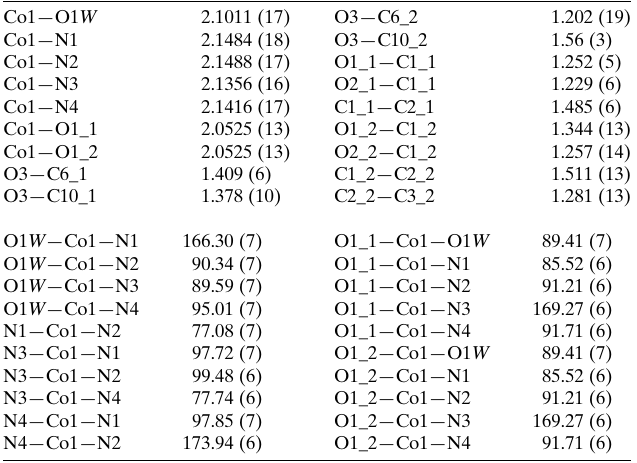
Table 1 Selected geometric parameters (A˚ , (cid:3) ).